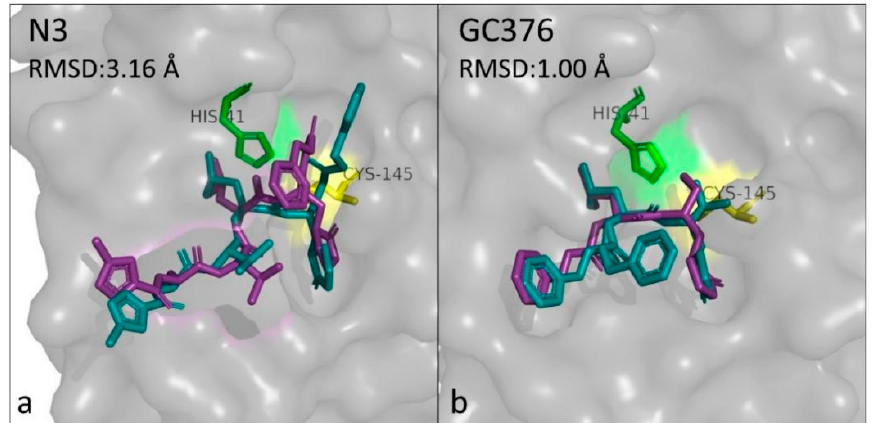
Figure 2. Superimposed binding modes of the inhibitors N3 ( a ) and GC376 ( b ) as occurring from the co-crystallization structure (PDB ID: 6LU7 and 7D1M, respectively) (petrol blue) and the molecular docking simulation (purple), respectively. The root-mean-square-deviation (RMSD) of the binding between the co-crystallized and docked complex is indicated.